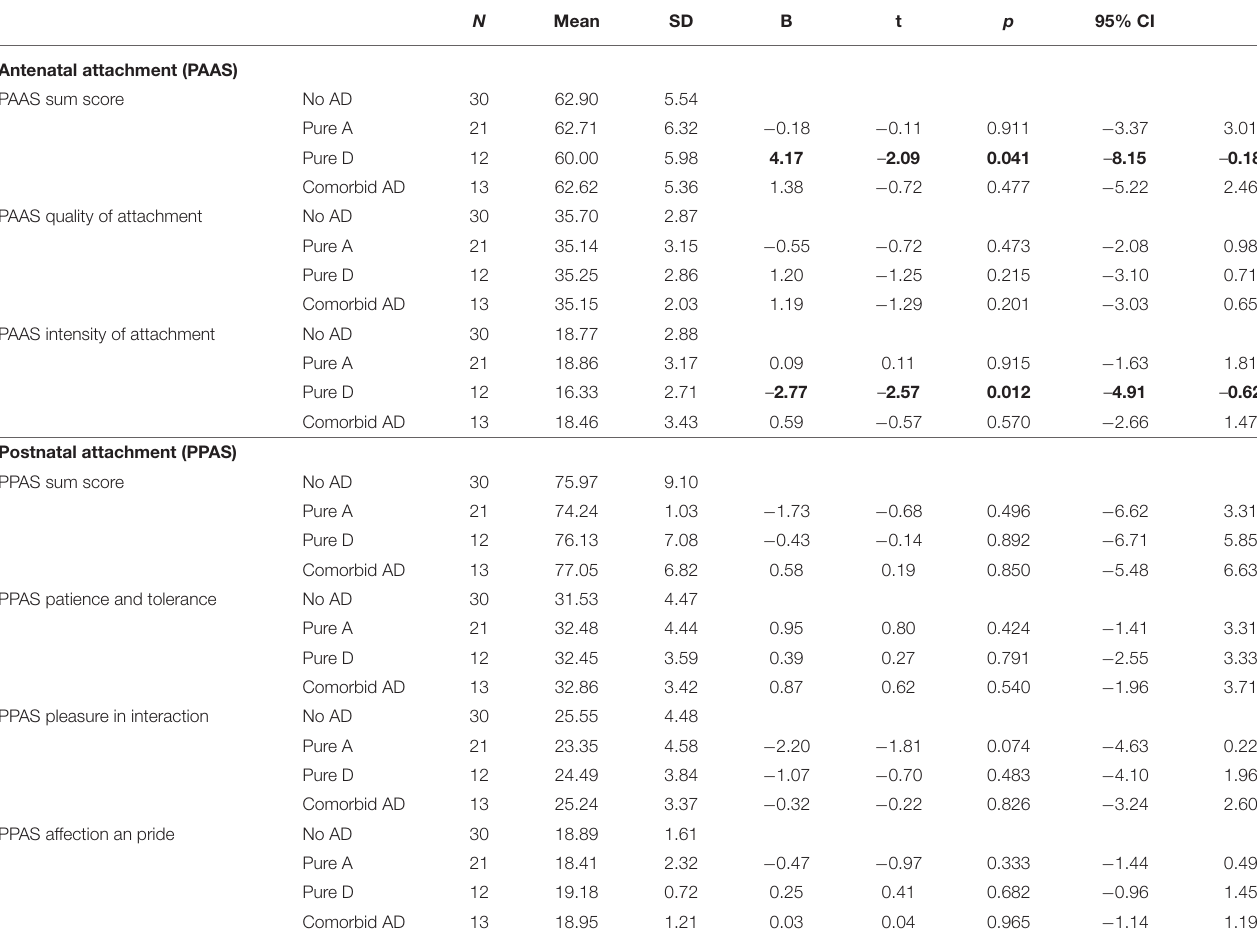
TABLE 3 | Prospective associations of paternal psychopathology with antenatal and postnatal father-to-child attachment. N Mean SD B t p 95% CI Antenatal attachment (PAAS) PAAS sum score